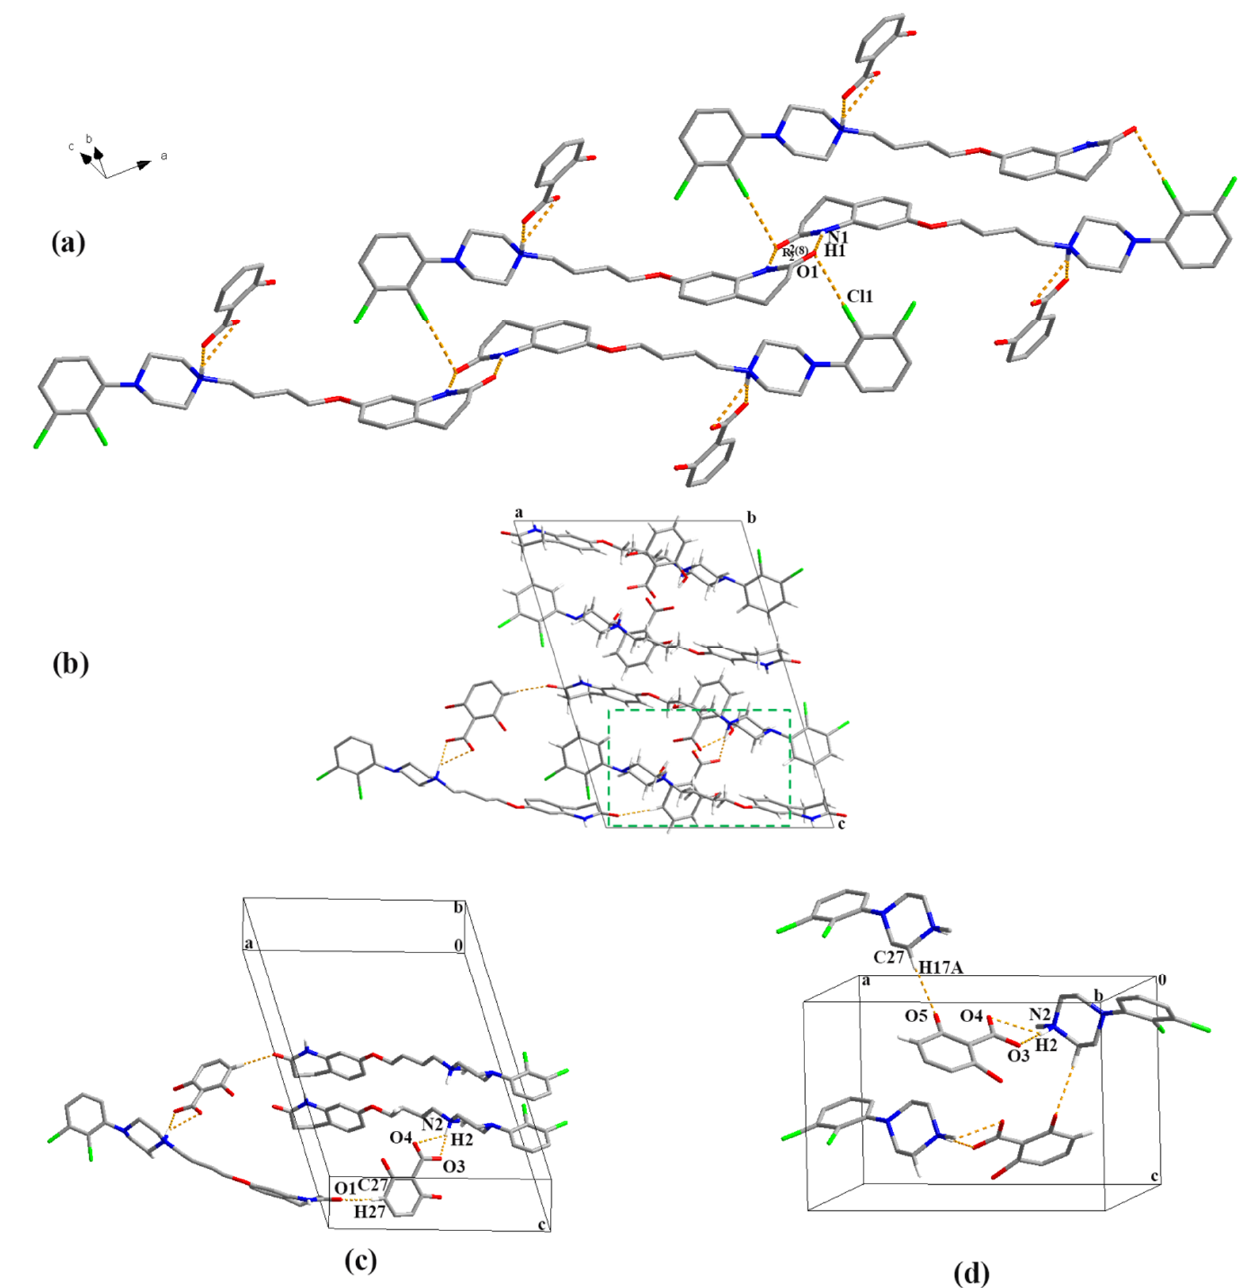
Figure 2. Packing diagrams of ARI-SAL salt: ( a ) the 1D ribbon was formed by N 1 -H 1 · · · O 1 hydrogen bond and short Cl 1 · · · O 1 interaction; ( b ) packing diagram for ARI-SAL salt viewed down the b axis and the green dashed wireframe indicates two different types of helices; ( c ) the type-1 helix was propagated by the bifurcated N-H · · · O hydrogen bond and weaker C 27 -H 27 · · · O 1 interactions; ( d ) the type-2 helix was propagated by the bifurcated N-H · · · O hydrogen bond and C 17 -H 17A · · · O 5 interactions (only a partial aripiprazole molecule was drawn for clarity).